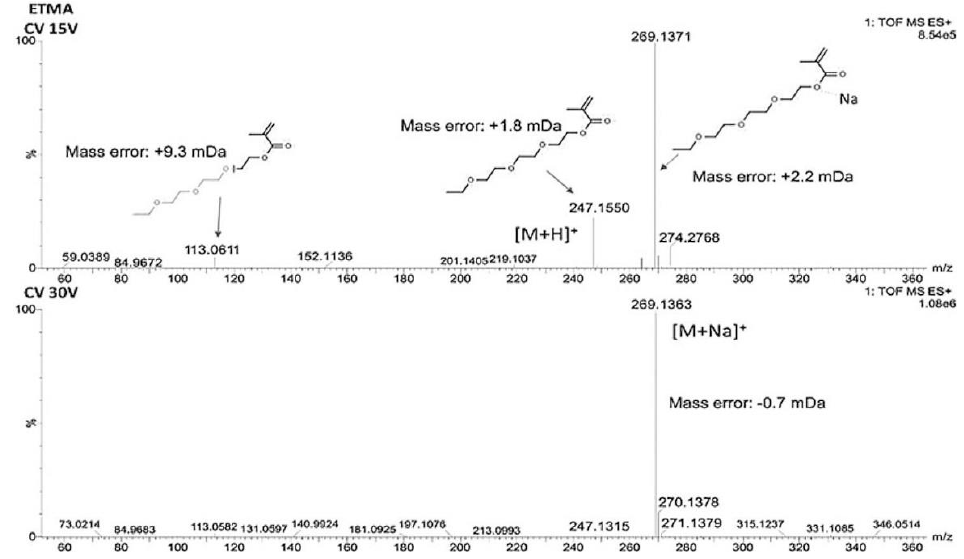
Figure 6. Identification of ethoxytriethylene glycol methacrylate in 50% ethanol using 15 V and 30 V cone voltages. Reproduced from [20].